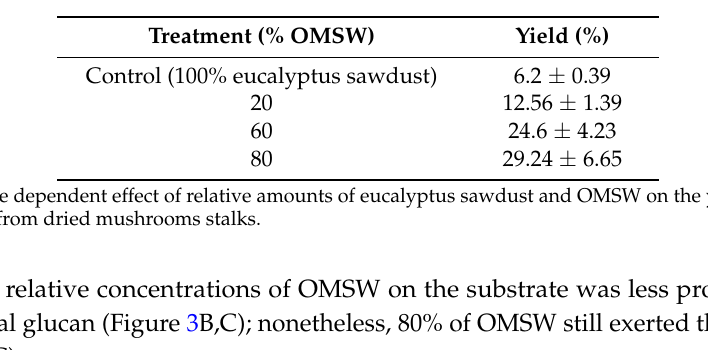
Table 2. The effect of cultivation of Pleurotus eryngii mushrooms in various relative amounts of eucalyptus sawdust and olive mill solid waste (OMSW) on yield of preparation of extracted glucans fraction.